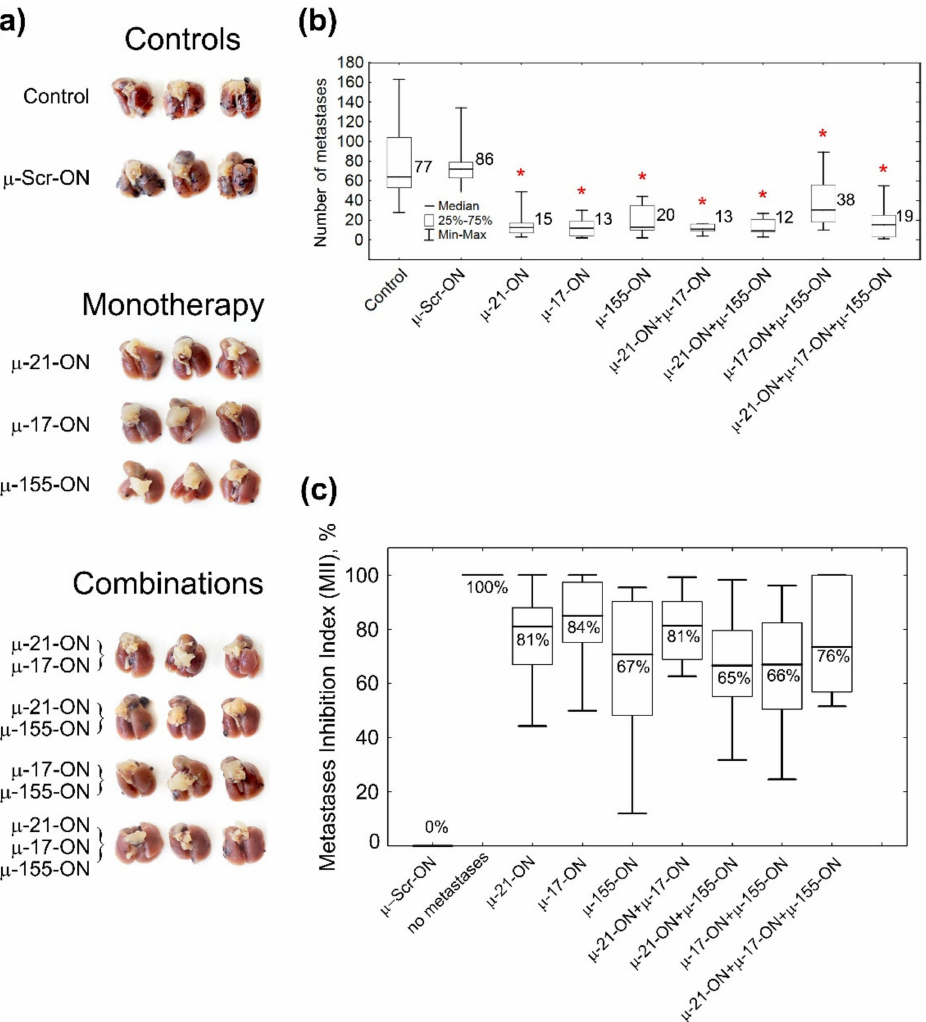
Figure 5. Antimetastatic effect of miRNA-targeted µ -oligonucleotides. ( a ) Photographs of formalin- fixed lungs with melanoma B16 metastases. ( b ) Box plot showing the number of surface metastases in lungs in each group. Numbers on the right side of the boxes show average number of lung surface metastases in the group. Red asterisk shows statistically significant difference from µ -Scr-ON and Control groups with p ≤ 0.0001. ( c ) Box plot showing the Metastases Inhibition Indexes (MIIs) in each group. 0% corresponds to the area of metastases in the µ -Scr-ON group, 100% corresponds to the complete absence of metastases. Melanoma B16 cells were transfected with µ -oligonucleotides followed by intravenous injection to C57Bl/6 mice. Control—cells treated with Opti-MEM. Total concentration of µ -oligonucleotides upon transfection was 150 nM: single ( µ -Scr-ON, µ -21-ON, µ -17- ON or µ -155-ON) 150 nM; pairs ( µ -21-ON/ µ -17-ON, µ -21-ON/ µ -155-ON, µ -17-ON/ µ -155-ON)—75 nM; triple cocktail ( µ -21-ON/ µ -17-ON/ µ -155-ON)—50 nM each. Transfection was performed in complex with Lipofectamine™2000. Numbers below the median in the boxes show average MII in the group. The data were statistically analyzed with one-way ANOVA using a Tukey